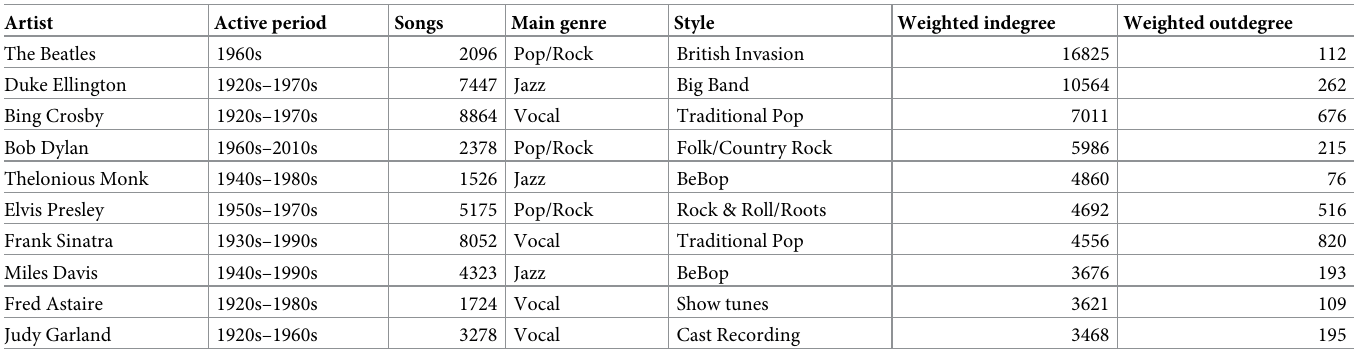
Table 2. Top 10 artists by number of covered songs (weighted